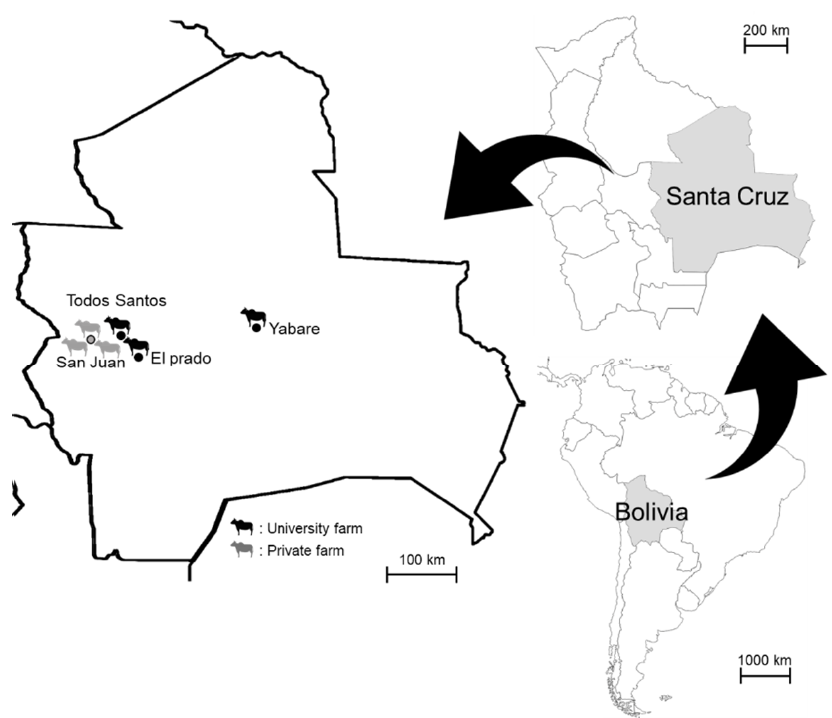
Figure 1. Geographical location of the study farms in Santa Cruz, Bolivia.